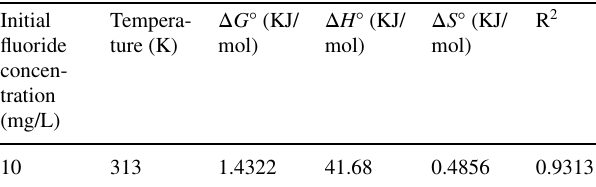
Table 5 Thermodynamic parameters of BISAB at 313